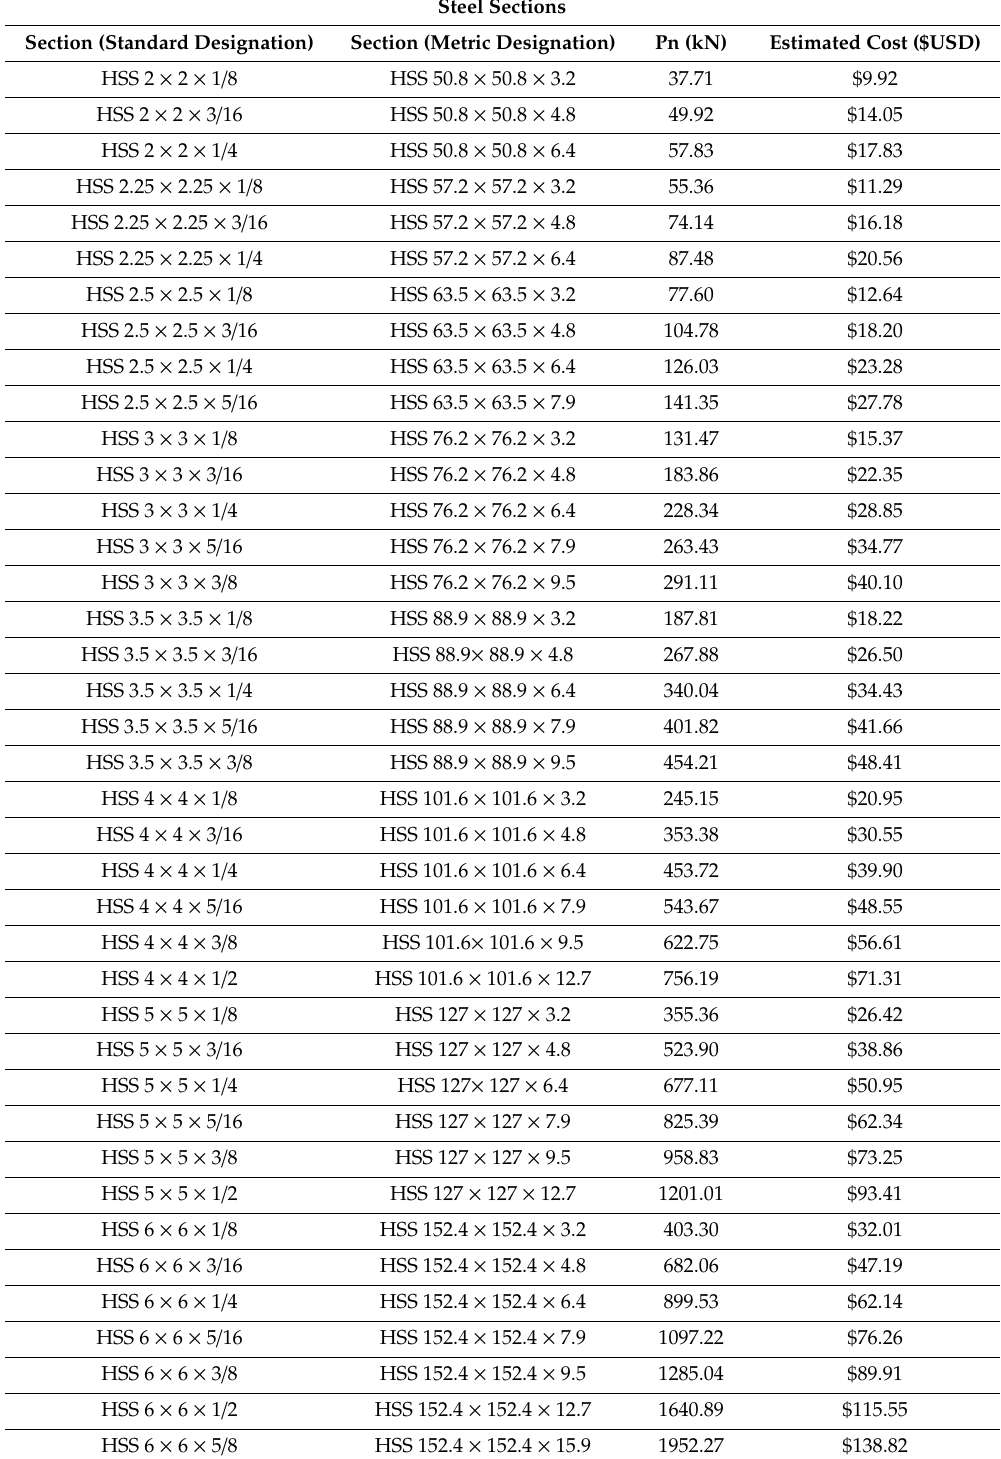
Table 3. The costs assumed for the steel sections. This is based on a current (as of 1 April 2020) price of steel plate of USD 0.77 per kg. The assumed column length is 3050 mm (10